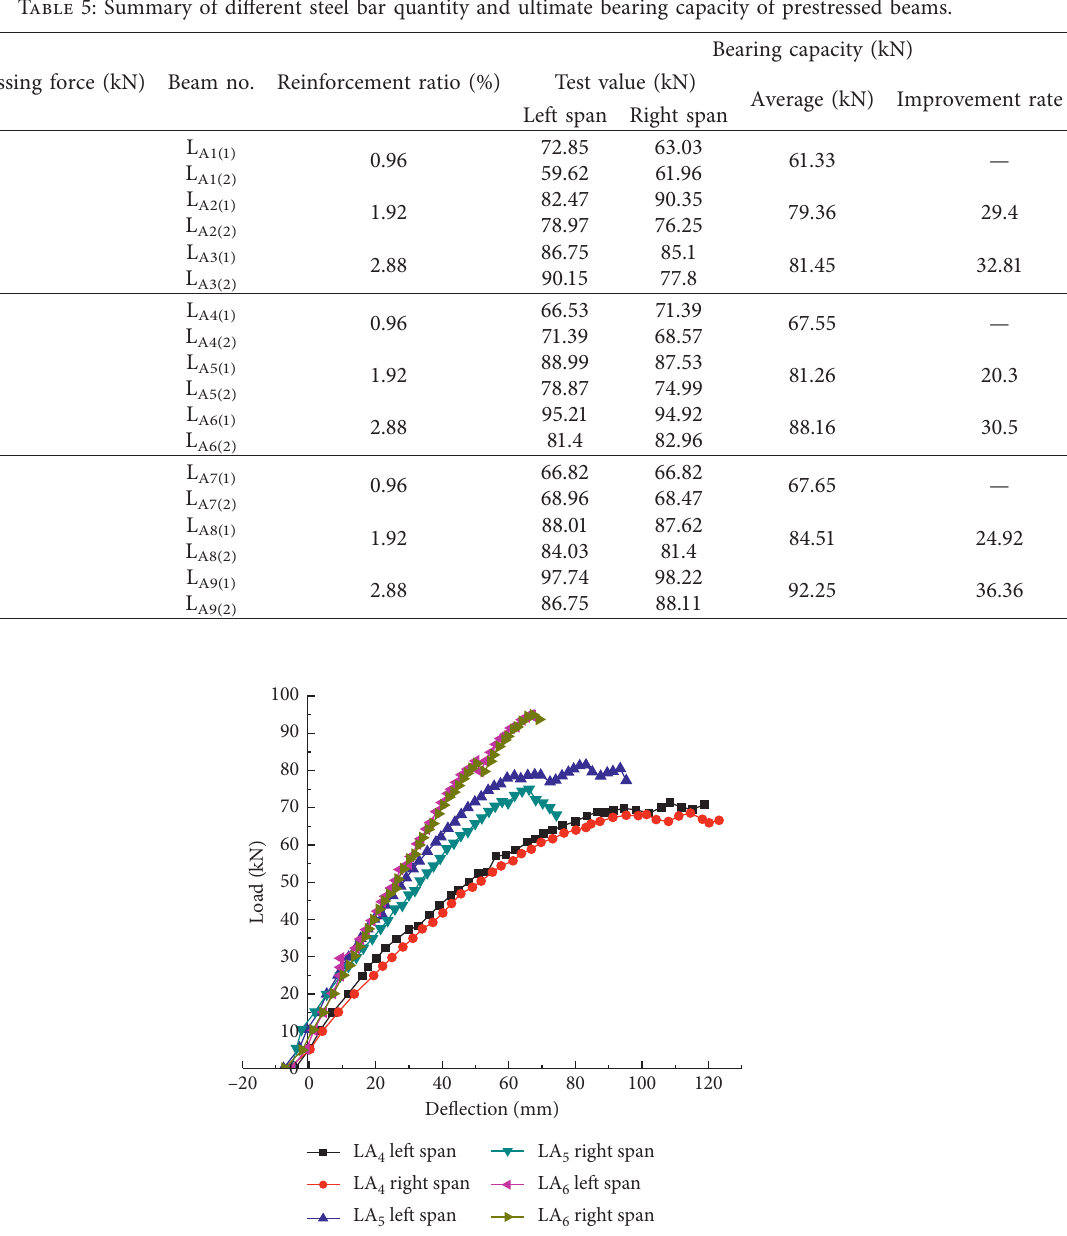
Table 5: Summary of different steel bar quantity and ultimate bearing capacity of prestressed beams.